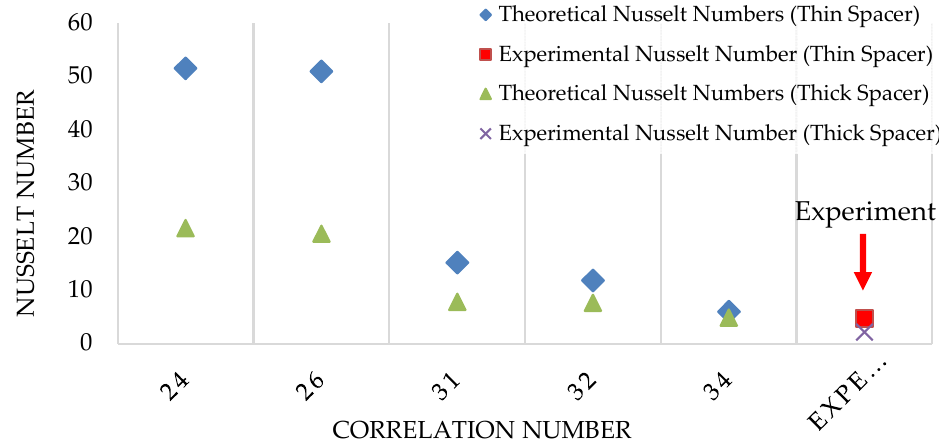
Figure 16. Correlations for spacer-filled channels with flow rate (5 L/min).